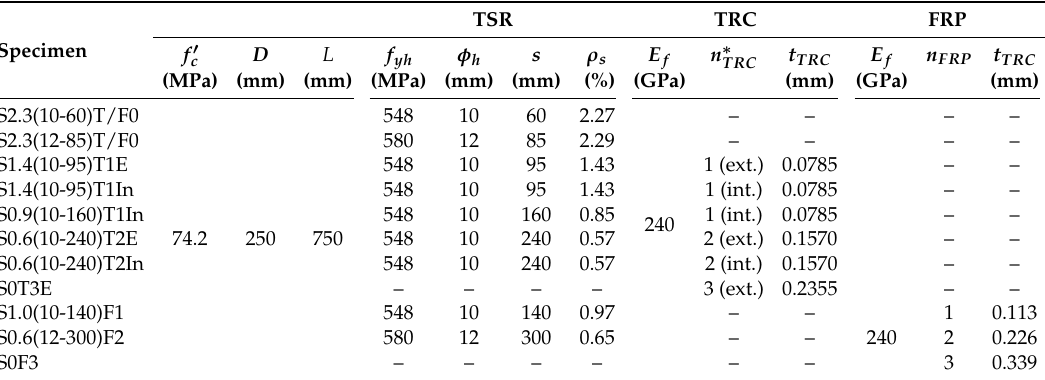
Table 1. Specimens’ details.